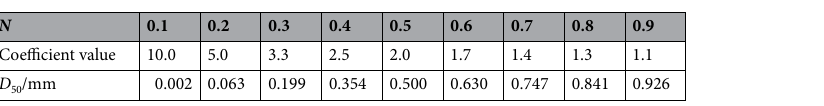
Table 2. Calculated values of D 50